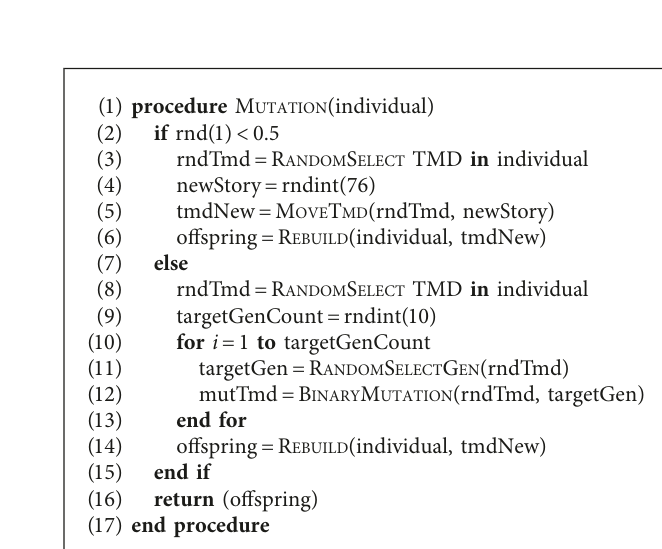
Figure 6: Crossover